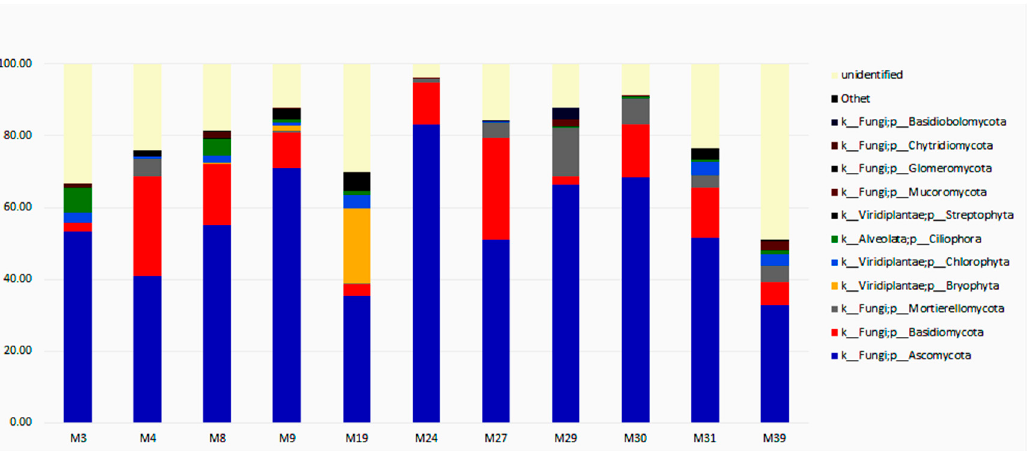
Figure 4. Taxonomic structure of the fungal community at the phylum level in the studied soils, % of the total number of sequences in the sample according to ITS data.